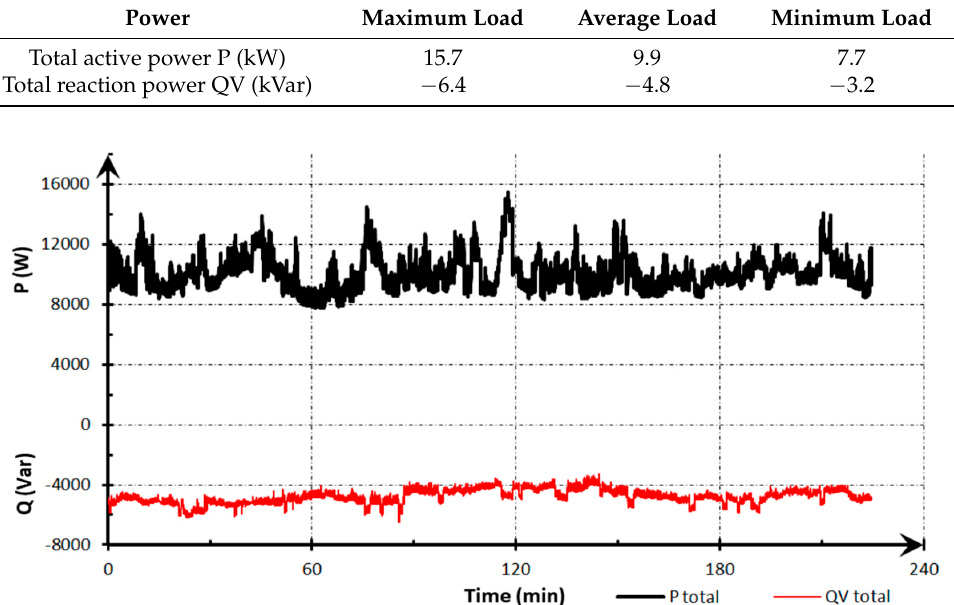
Table 3. Recorded total requirement for power of the monitored facility.